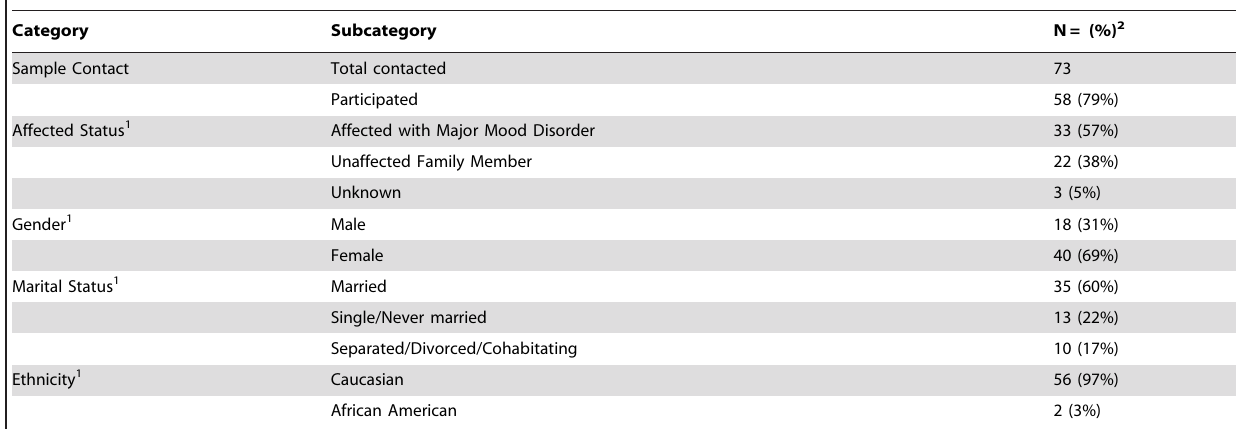
Table 1. Participant